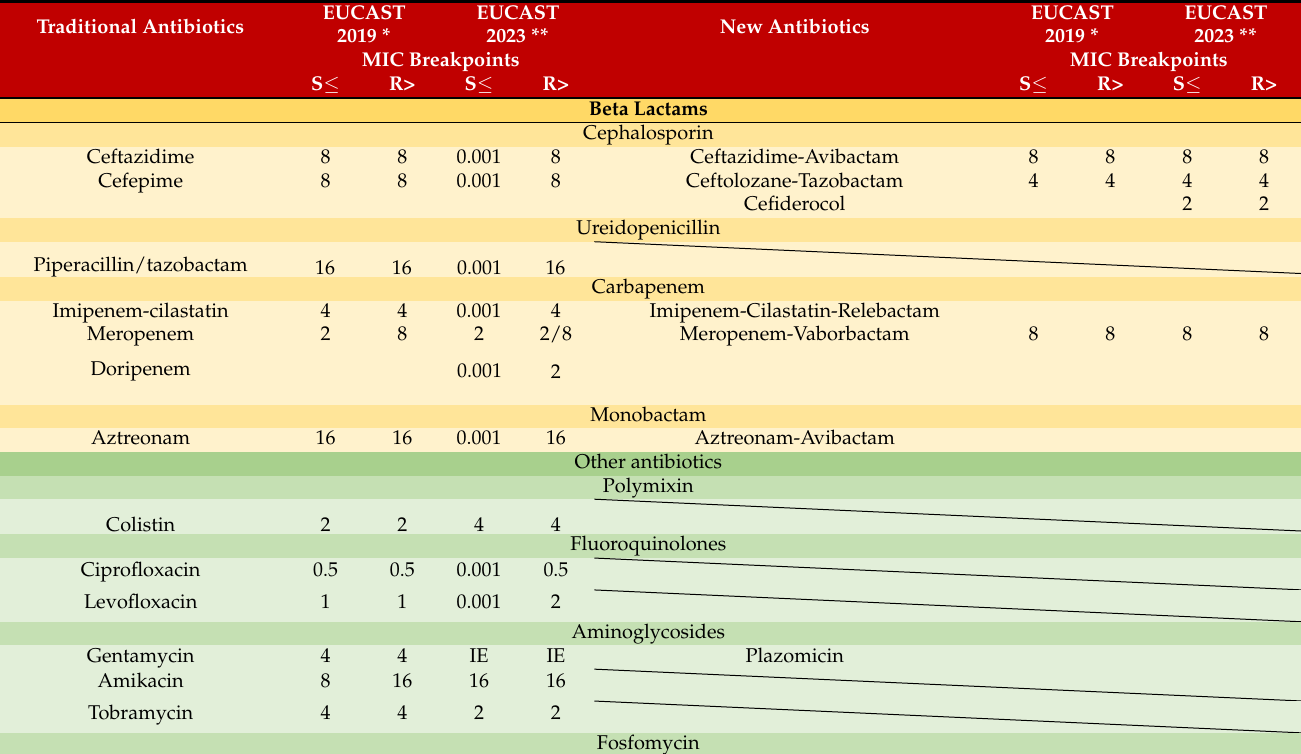
Table 2. Antipseudomonal agents and the dynamics of their MIC breakpoint